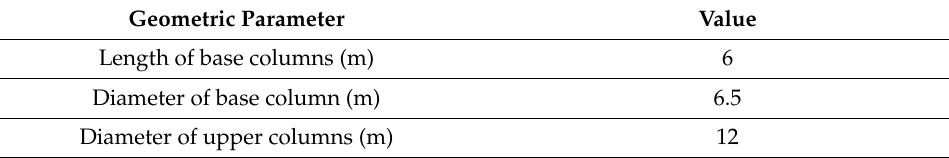
Table 1. Cont. Geometric Parameter Value Length of base columns (m) 6 Diameter of base column (m) 6.5 Diameter of upper columns